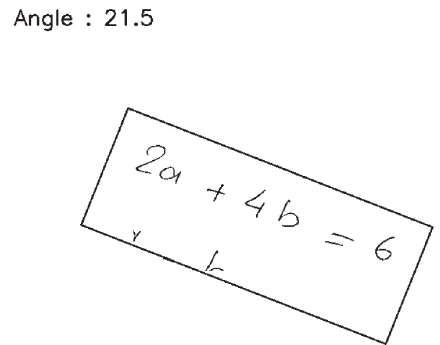
Figure 11: Defining rectangle around character